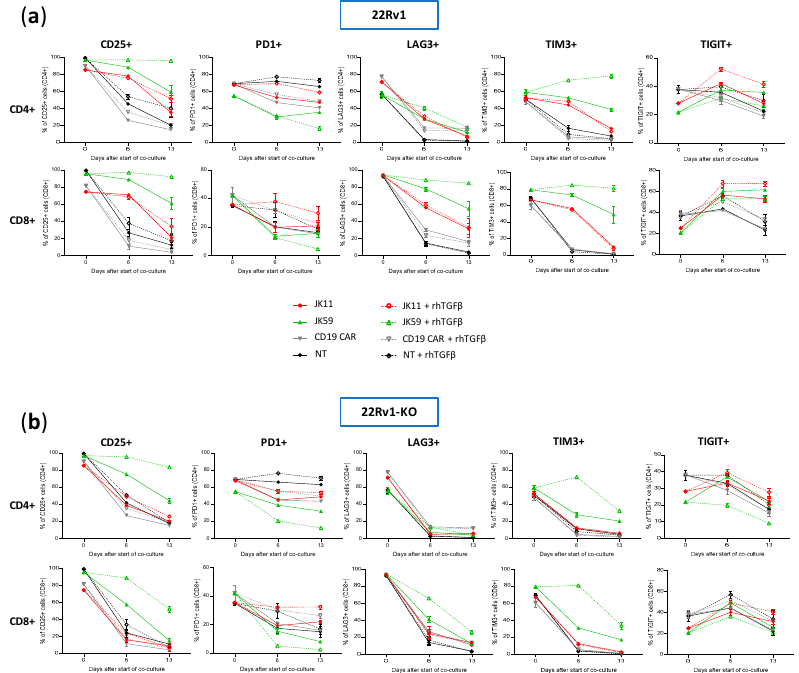
Figure 7. Analysis of STEAP1 and SwR-STEAP1 CAR T cell phenotyping after repeated in vitro stimulation of STEAP1 + tumor cells. Long-term co-culture was achieved by stimulating every 3 to 4 days the JK11, JK59, and CD19 CAR T cells and NT T cells, with irradiated 22Rv1 and 22Rv1-KO target cells at an E:T ratio of 1:1 in the absence or presence of 10 ng/mL rhTGF β . Before the start of the co-culture (day 0), at day 6, and day 13, CAR T cell phenotyping was assessed with flow cytometry. ( a , b ) The CD4 + and CD8 + T cell populations co-cultured with 22Rv1 target cells ( a ) or with 22Rv1-KO target cells ( b ) were assessed for surface expression of the activation marker CD25 and the checkpoint receptors PD1, LAG3, TIM3, and TIGIT. Background staining for each marker was identified using Fluorescence Minus One controls (see Figure S7a–c for gating strategy). Data represent the mean values ± SEM from two healthy donors. Each co-culture was performed in duplicate, and these were kept separate throughout the assay.